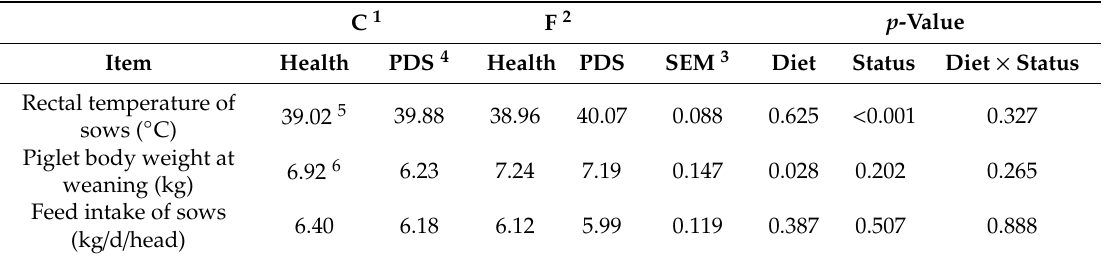
Table 3. E ff ect of Bacillus licheniformis -fermented products and postpartum dysgalactia syndrome on the rectal temperature, piglet body weight at weaning of sows, and feed intake.